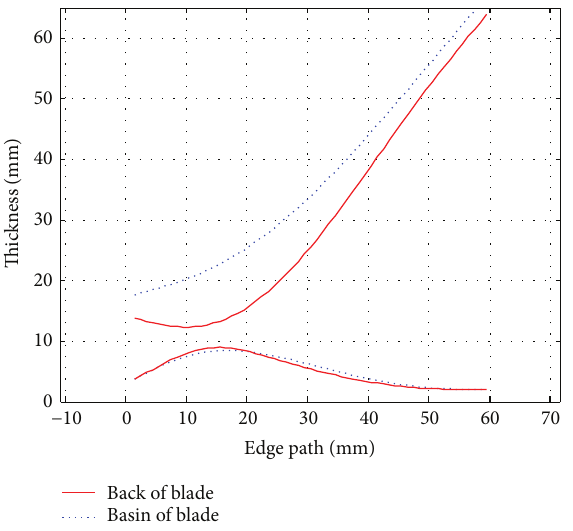
Figure 6: Instantaneous blade thickness curve.